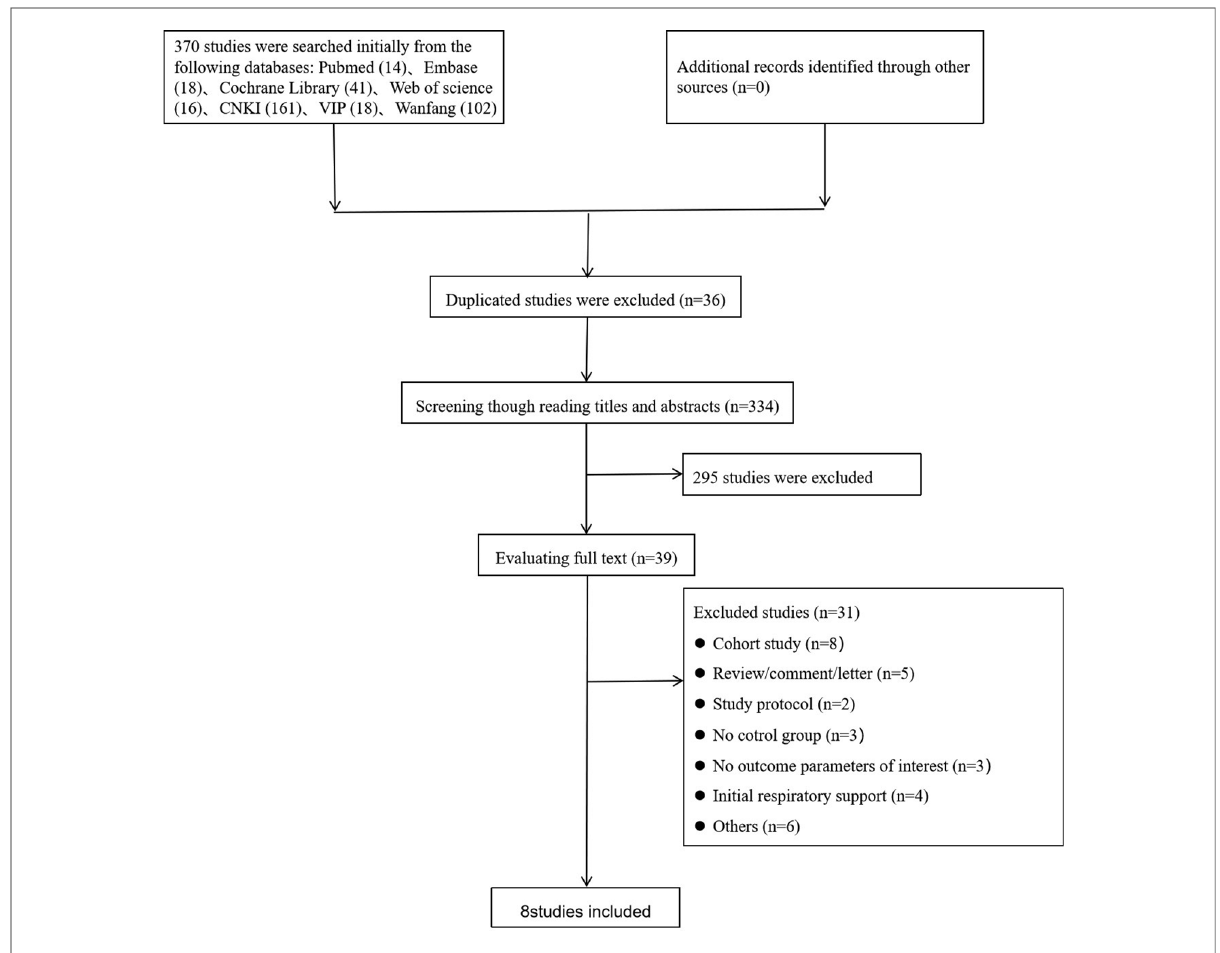
FIGURE 1 Flow diagram of the identi fi cation and selection of